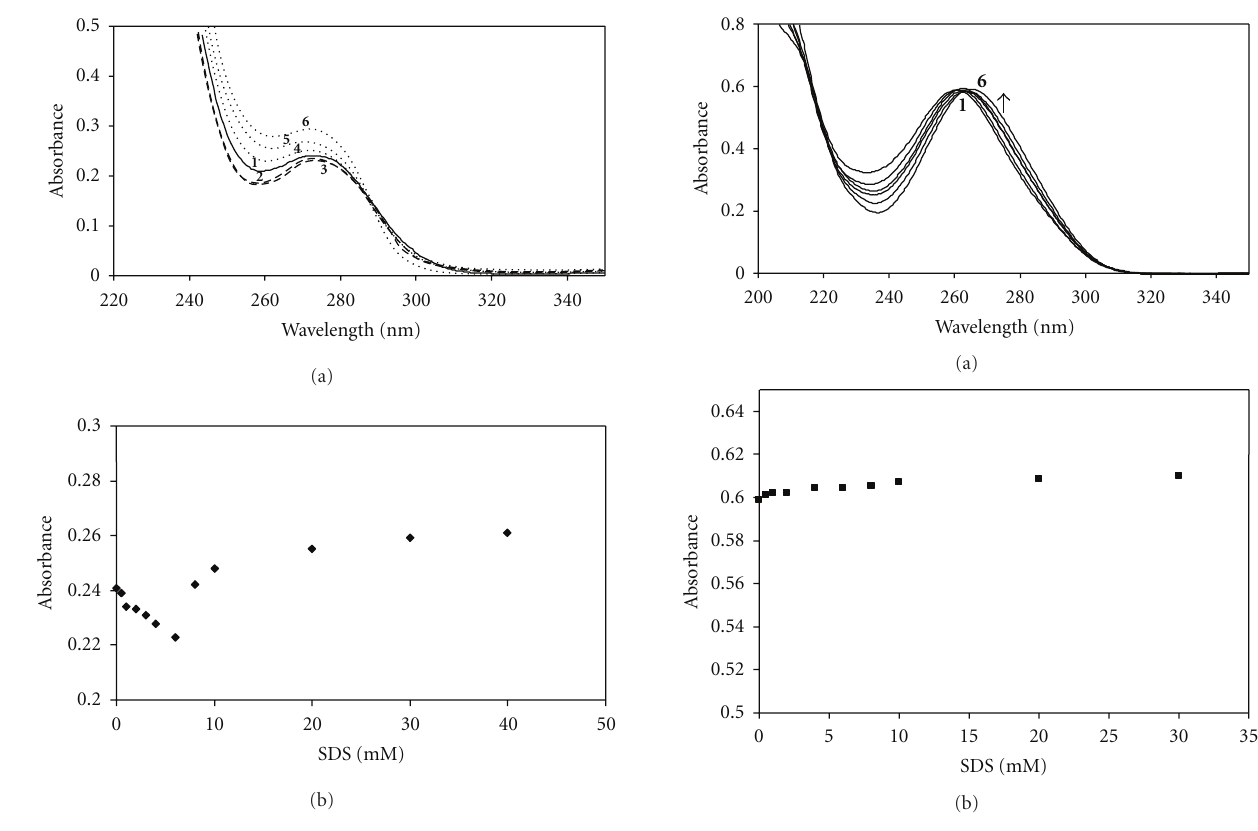
Figure 3: (a) Visible absorption spectra of SMX (4 . 0 × 10 − 5 M) at various concentrations of SDS at 298 K: (1) no SDS, (2) 2mM, (3) 4mM, (4) 8 mM, (5) 10mM, (6) 20 mM SDS. (b) The absorbance change of 4 . 0 × 10 − 5 M SMX (below and above the CMC) with the concentration of